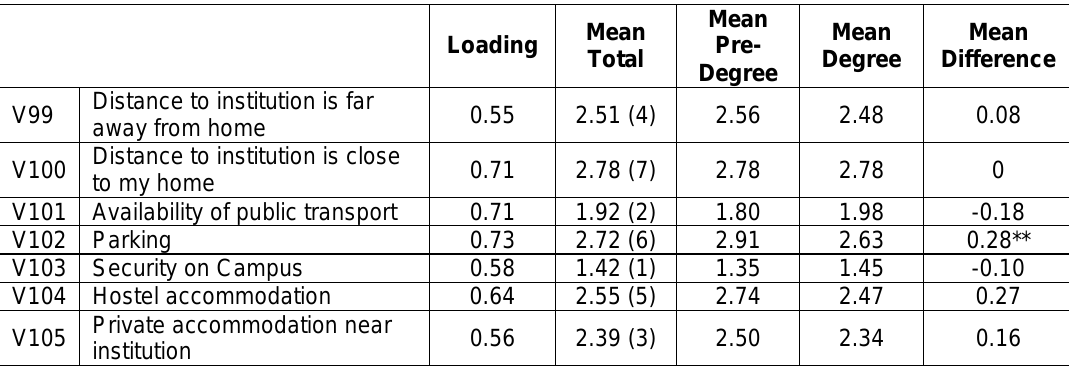
Table 1: Operational activities